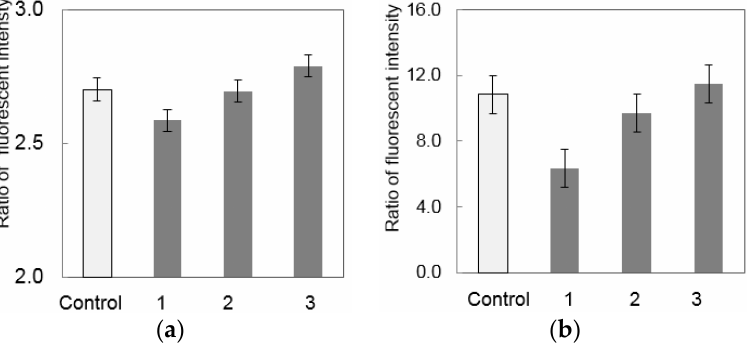
Figure 4. Evaluation of the efficiency of PCR for the number of washes. ( a ) RFI of FAM for the invA gene; ( b ) RFI of ROX for the internal control DNA. Error bars indicate standard deviation (SD) ( n = 3).